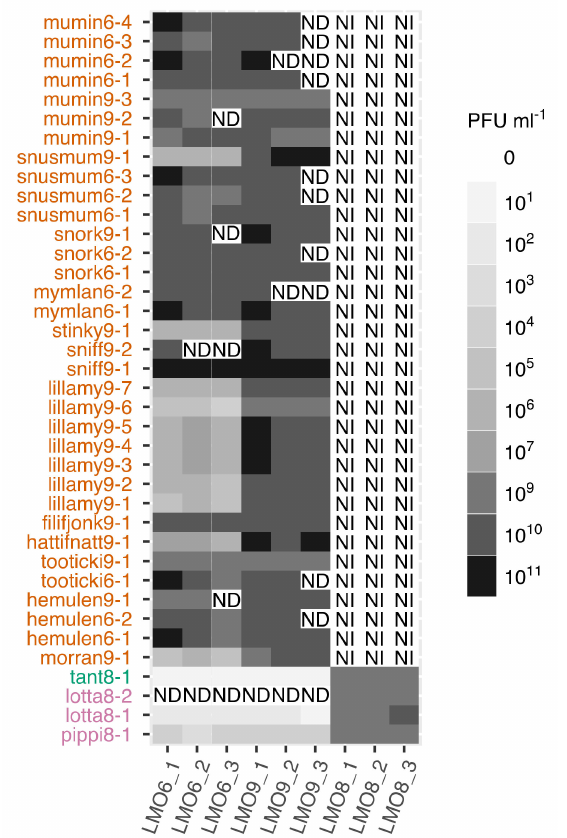
Figure 7. Host range tests for the type phages within each species with the three bacterial strains used within this study. ND = not determined, i.e., when the plaque assay has not been made; NI = no infection, i.e., when a plaque assay was performed but no plaques were detected. Phages are coloured according to genus, as in Figure 2. The number after, e.g., “mumin” indicates which bacterial strain the phage was originally isolated on, namely, 6 for LMO6, 8 for LMO8 and 9 for LMO9. The names on the x -axis are which bacterial strain the e ffi ciency of plating was performed on, as well as if it was the first, second or third replicate (_1, _2, or